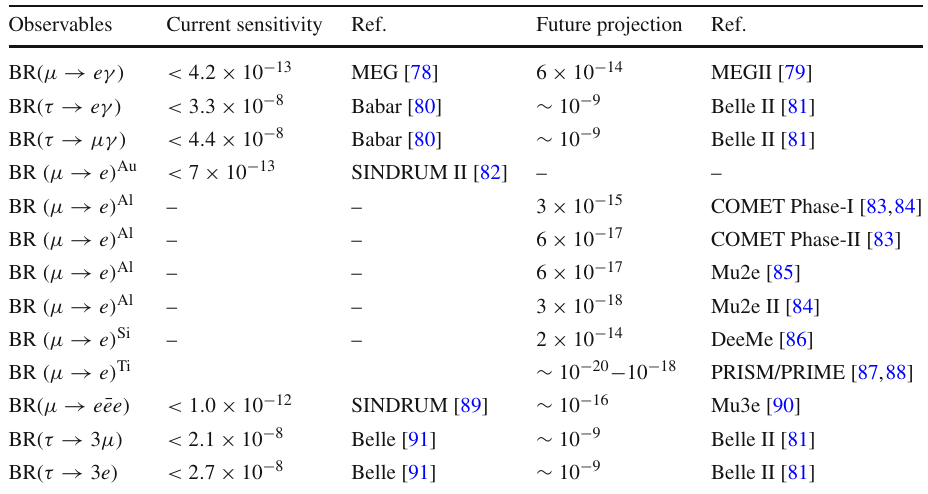
coming from the decays τ → e γ and τ → μγ are weaker than that of the decay μ → e γ . Therefore, they are not shown in this work.